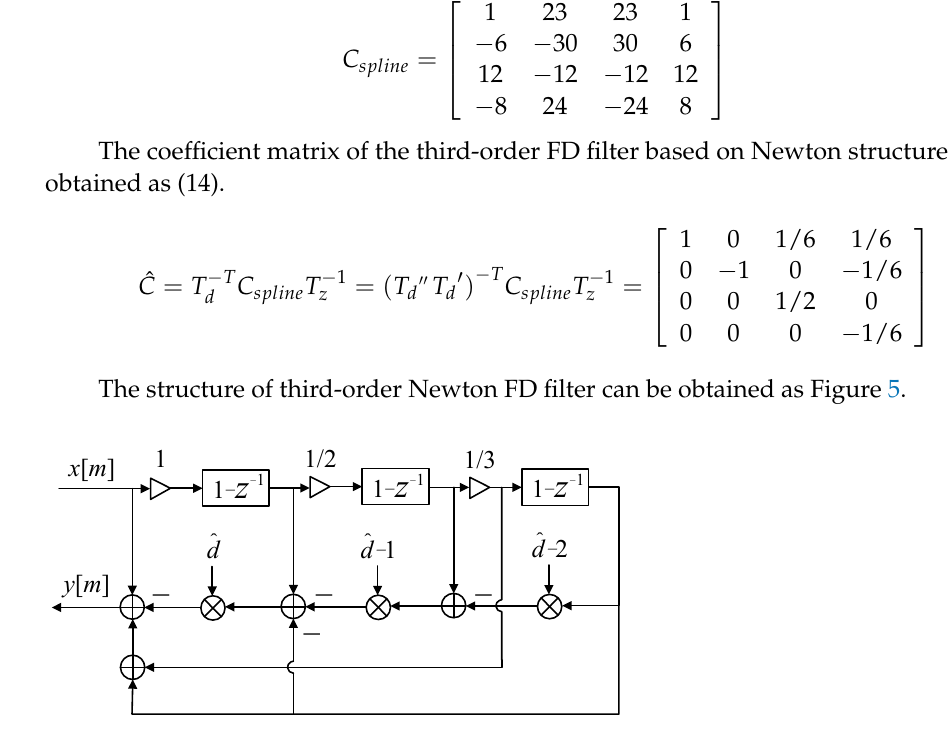
Figure 5. Structure of third-order Newton FD filter.